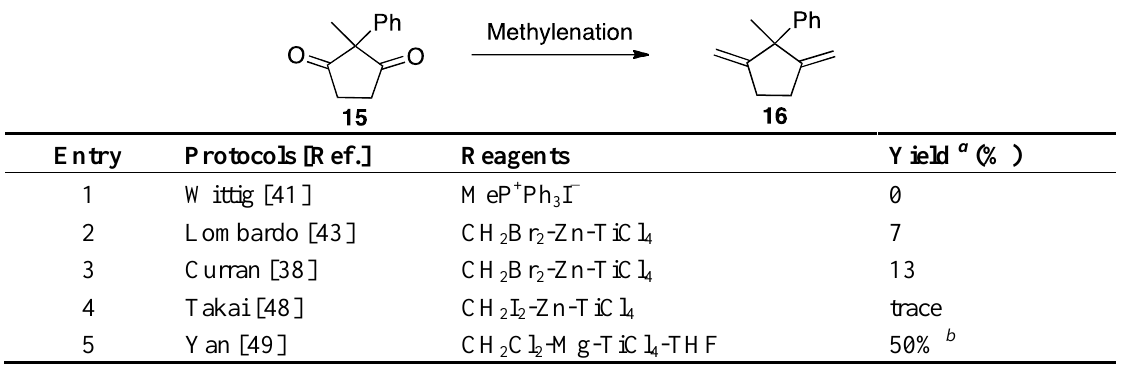
Table 3. Methylenation of diketone 15 by different protocols.